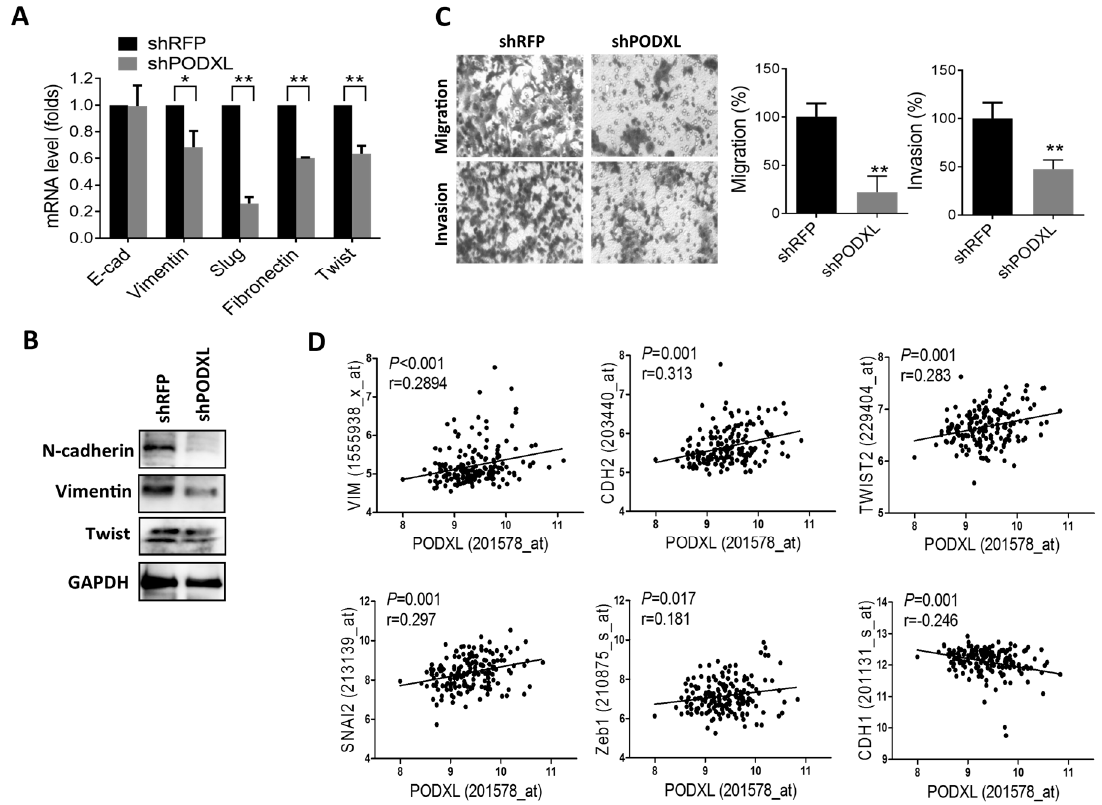
Figure 4. PODXL regulates epithelial-mesenchymal transition (EMT) gene expressions and tumor invasiveness. ( A and B ) Knockdown of PODXL-downregulated EMT-related gene expressions, as determined by real-time PCR ( A ) and Western blot ( B ) analyses. * p < 0.05; ** p < 0.01, as assessed by an unpaired t -test. ( C ) Inhibition of PODXL-suppressed tumor migration and invasion. Pictures were taken at 200x magnification. Data were derived from three random fields by three independent experiments, and results are expressed as multiples of the control. ** p < 0.01, as assessed by an unpaired t -test. ( D ) Scatter plot analyses of the correlation between PODXL and EMT-related gene expressions in colon cancer patients (GSE17536). The correlation coefficient was determined by Spearman’s test.